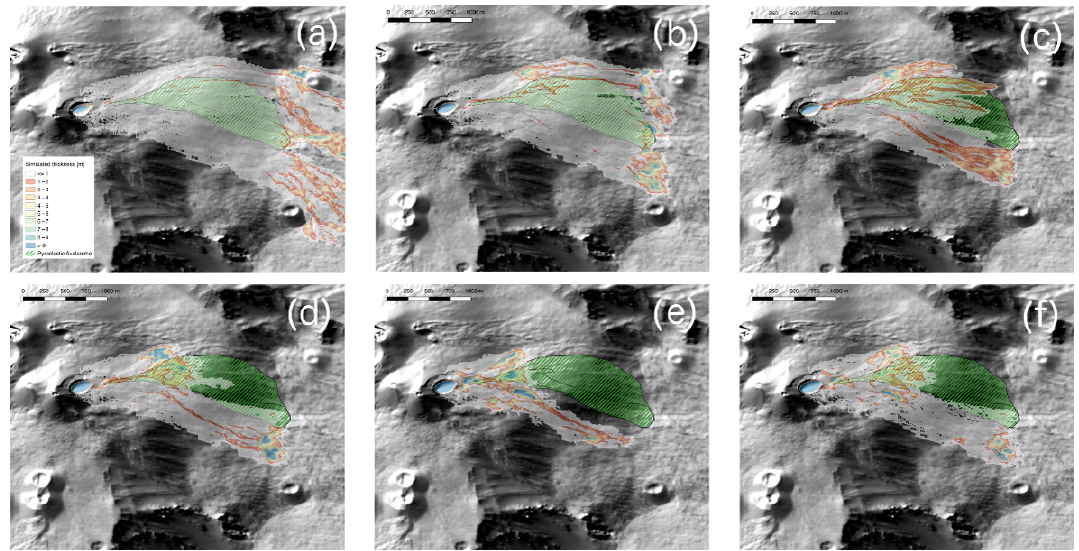
Figure 7. Results of IMEX_SfloW2D numerical simulations of a pyroclastic avalanche overlapped on the hill-shaded relief of the Etna summit and the boundaries of the 11 February 2014 event. Numerical parameters as follows: (a) µ = 0 . 1, ξ = 500; (b) µ = 0 . 2, ξ = 500; (c) µ = 0 . 2, ξ = 100; (d) µ = 0 . 3, ξ = 500; (e) µ = 0 . 4, ξ = 500; (f) µ = 0 . 4, ξ = 5000. Avalanche volume is equal to 0 . 5 × 10 6 m 3